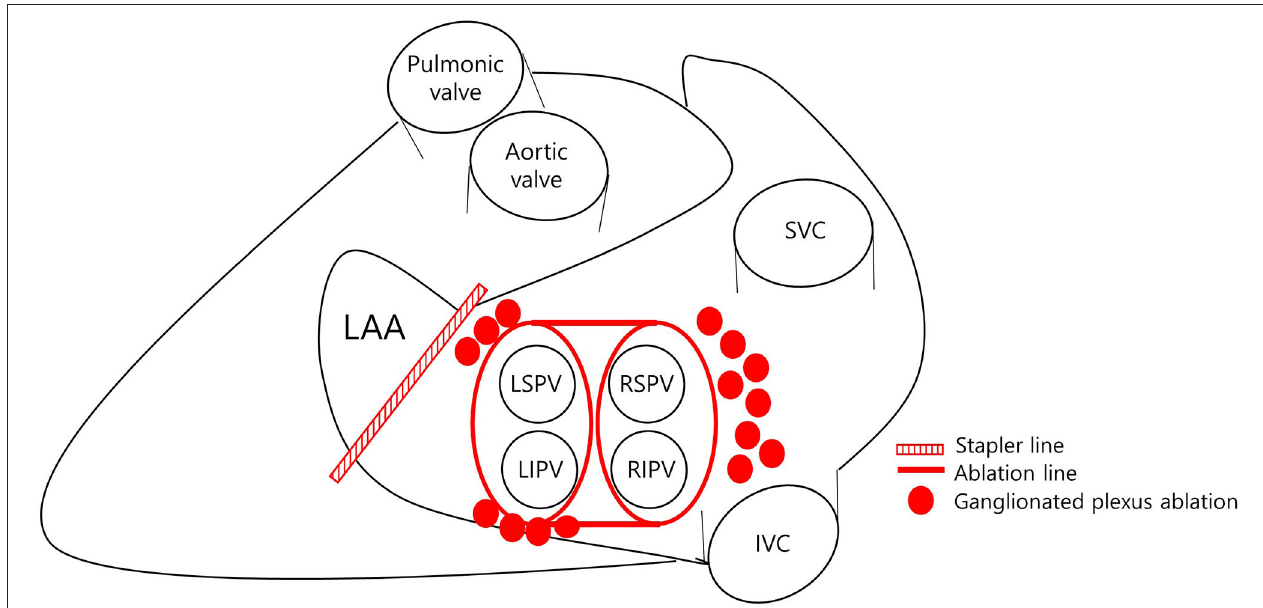
FIGURE 2 | Ablation strategy. LAA, left atrial appendage; LSPV, left superior pulmonary vein; LIPV, left inferior pulmonary vein; RSPV, right superior pulmonary vein; RIPV, right inferior pulmonary vein; SVC, superior vena cava; IVC, inferior vena cava.